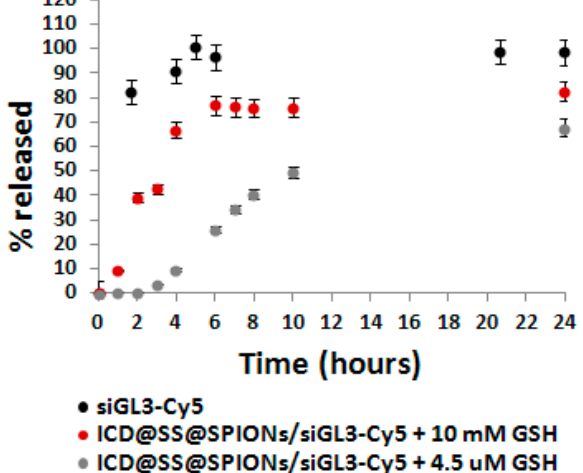
Figure 6. siRNA-Cy5 release from ICD@SS@SPIONs/siRNA-Cy5 in DPBS enriched with 4.5 µM or 10 mM GSH.